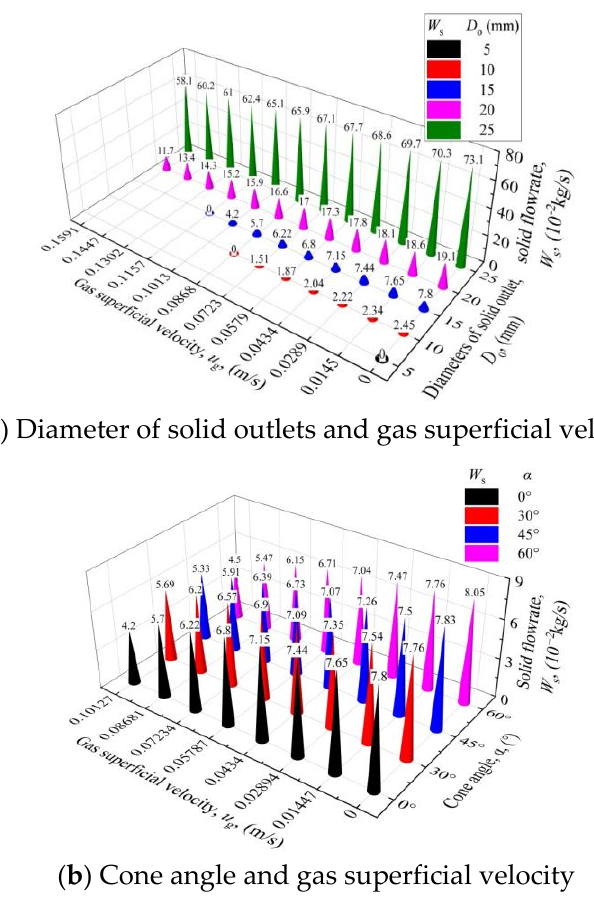
Figure 7. Solid flow rates under different conditions: diameter of solid outlets, cone angle and gas superficial velocity.